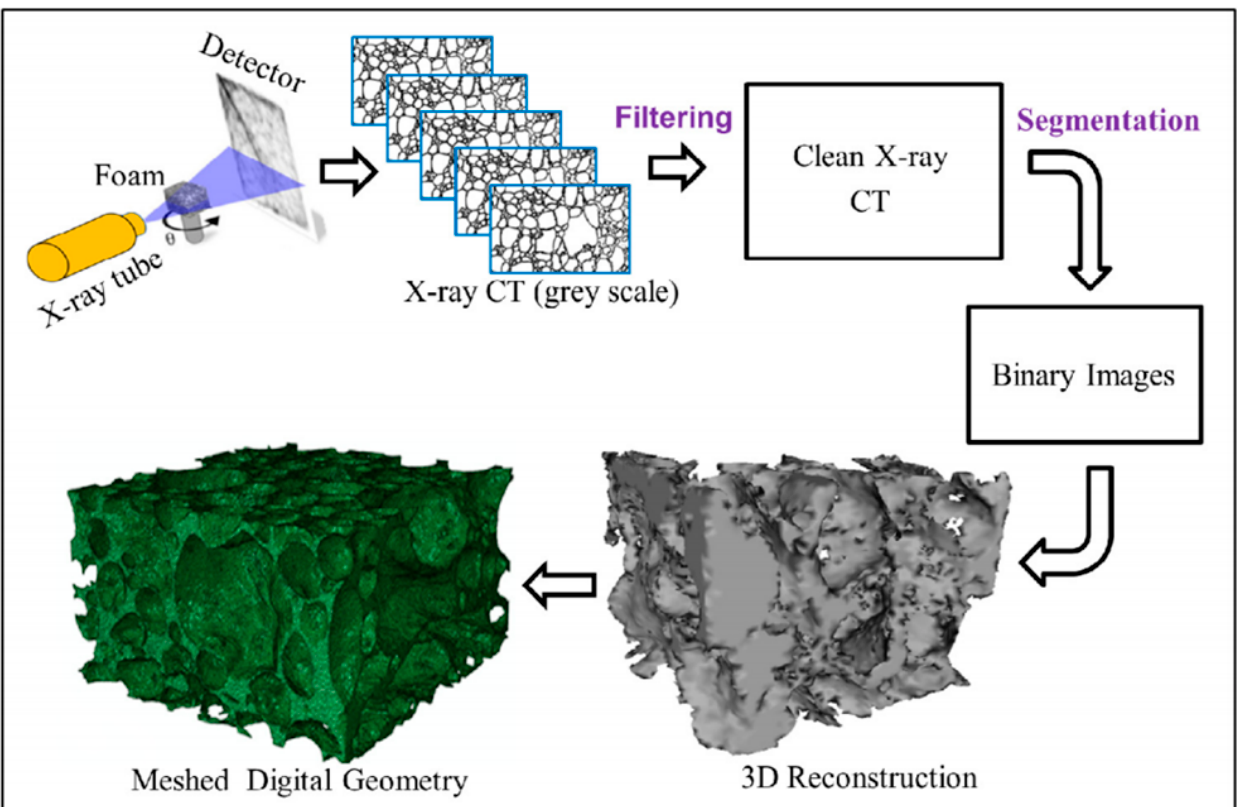
Figure 11. Flow chart of foam geometry development based on micro-CT: a flat panel detector and micro-focus X-ray source of 100 kV were used for imaging. The foam specimen was placed on a motor controlled rotating stage and radioscopic projections were taken after each degree of rotation. And the grey projections were transferred to binary images and processed to reconstruct full 3D digital foam geometry. Tetrahedral elements were used to mesh the geometry due to complex geometrical structure [34].